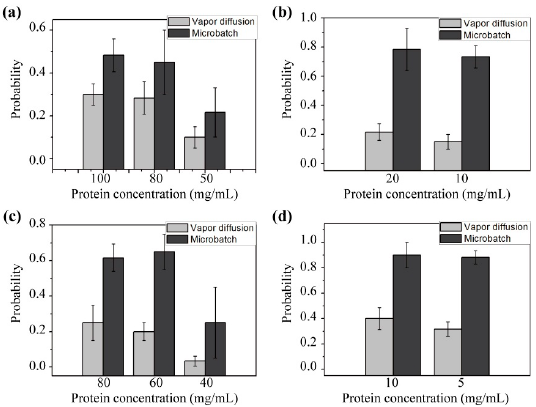
vapor diffusion method for: ( a ) Lysozyme; ( b ) Thaumatin; ( c ) Trypsin; ( d ) Horseradish peroxidase. Scale bars: 300 μm.